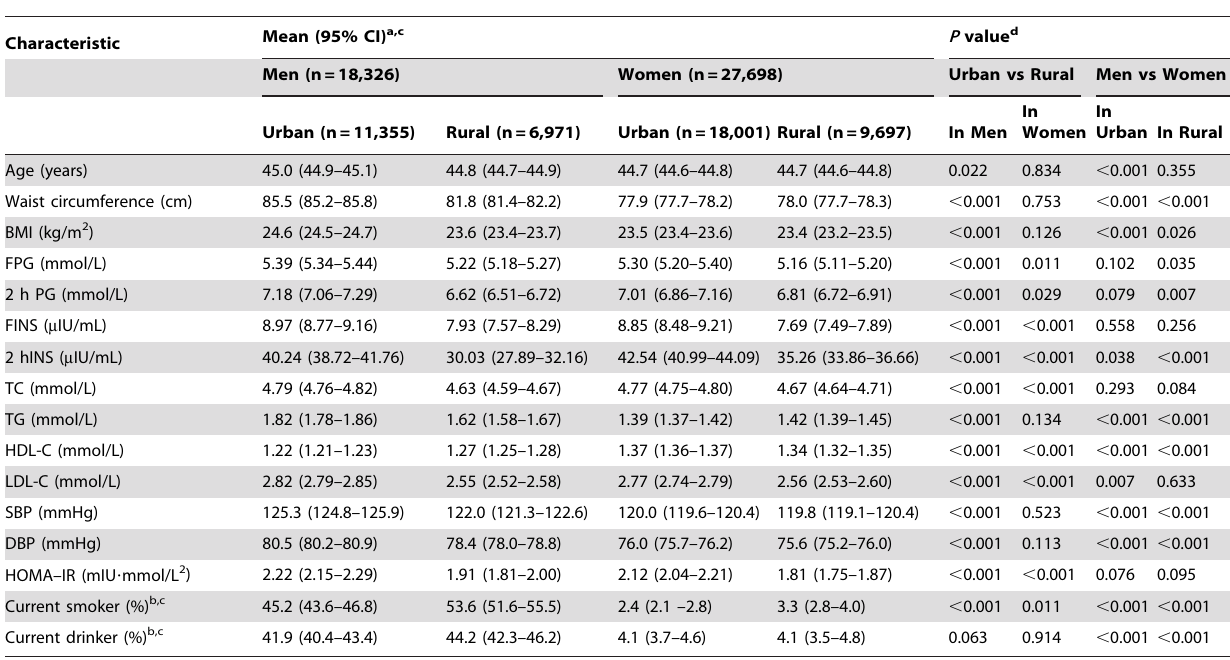
Table 1. Characteristics of 46,024 Participants by Gender and Region